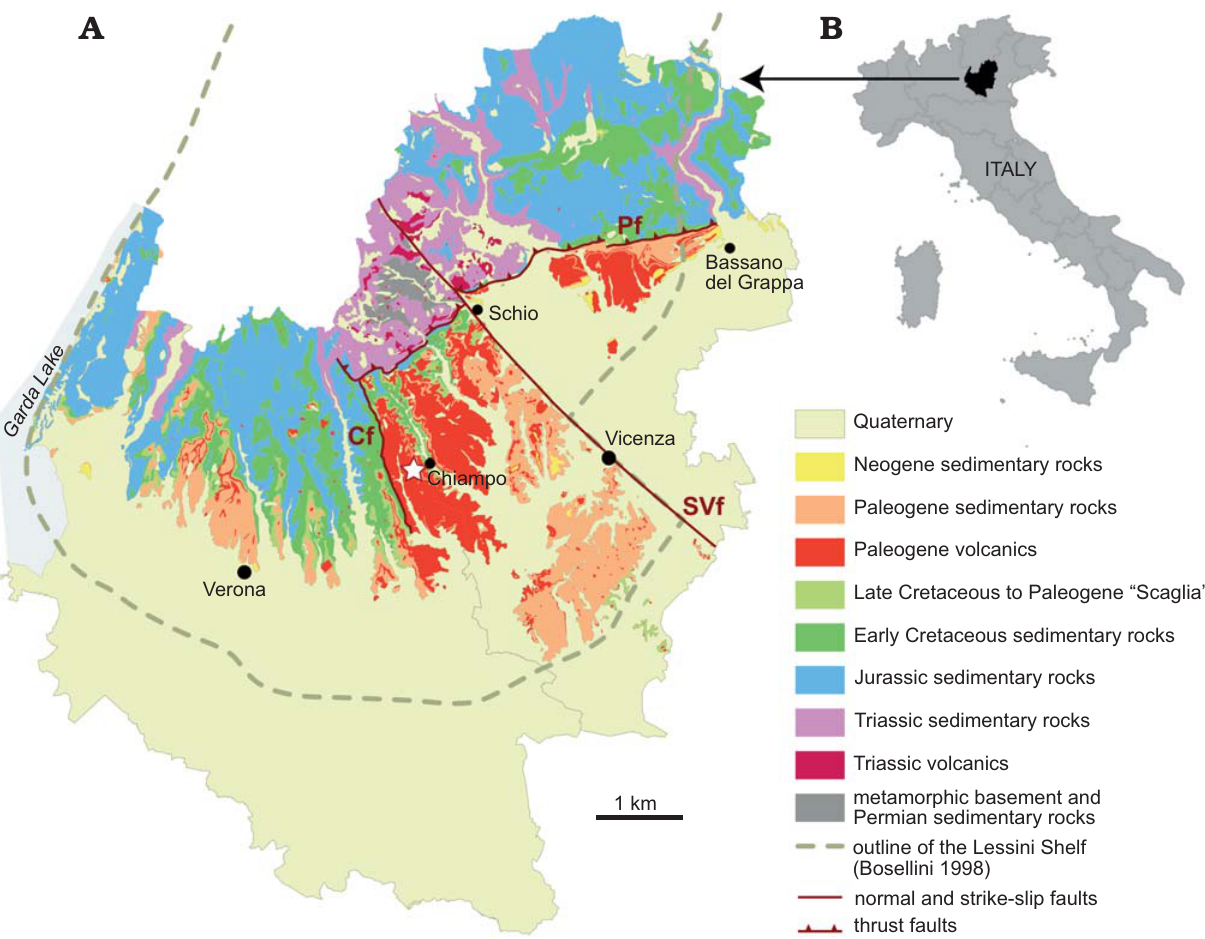
Fig. 2. Location ( B ) and geological map ( A ) of the study area (Verona and Vicenza provinces, Northern Italy), modified from http://gisgeologia.regione. veneto.it/, author: Regione Veneto, Sezione Geologia e Georisorse, and released under the Italian Open Data License 2.0 (https://www.dati.gov.it/content/ italian-open-data-license-v20). Outline of the Lessini Shelf during the Eocene modified from Bosellini (1989). The sponge-bearing outcrop is indicated by the white star near Chiampo. Cf, Castelvero fault; SVf, Schio-Vicenza fault; Pf, Pedemontana thrust fault.